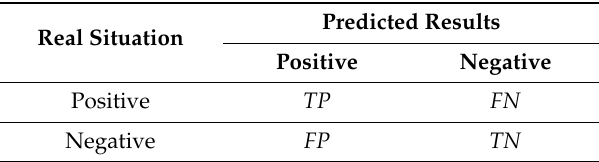
Table 4. The confusion matrix of the binary classification